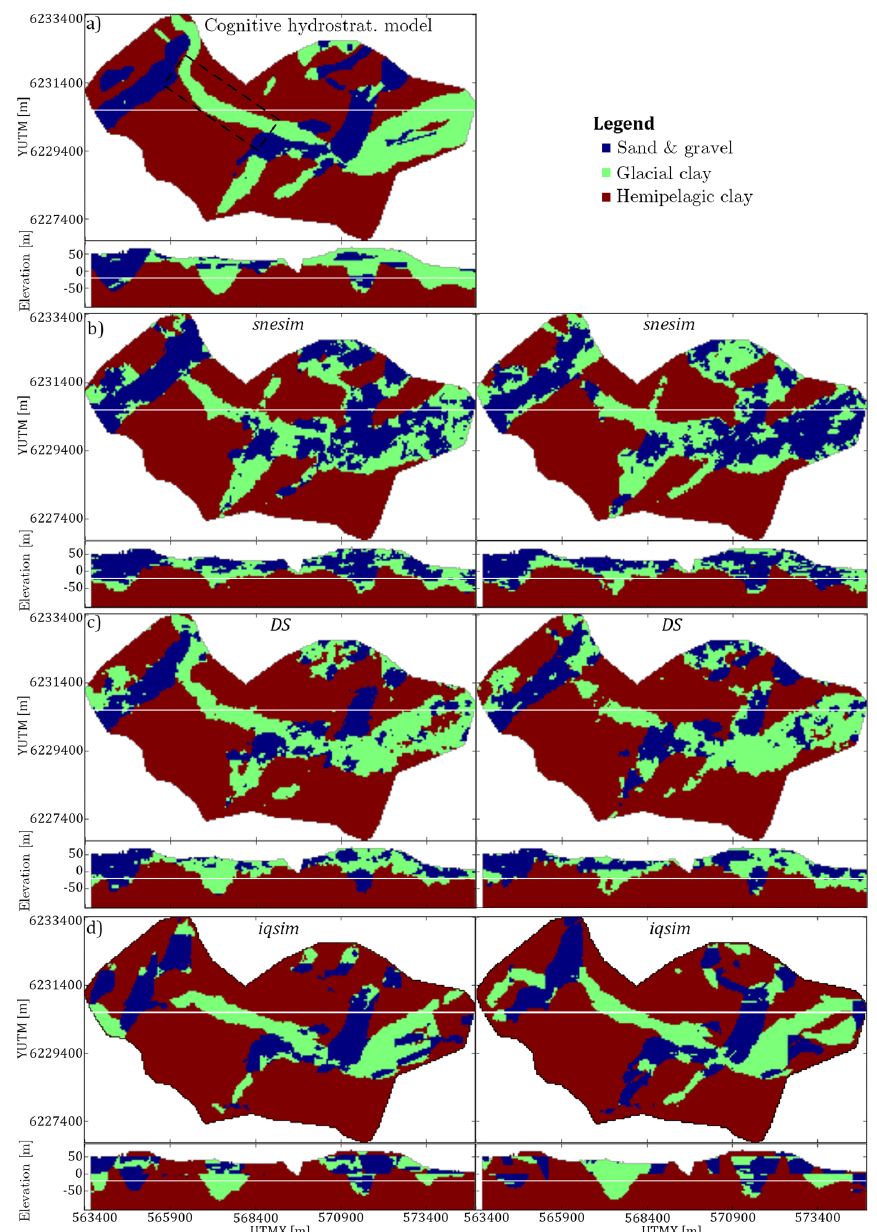
Figure 8. The hydrostratigraphic MPS realizations are presented as horizontal slices centered on 20mb.s.l. and vertical cross sections intersecting at UTMY 6230150m. (a) shows the cognitive hydrostratigraphic model, with a west–northwest- to east–southeast-trending glacial clay valley marked by a box; (b) shows two snesim realizations; (c) shows two DS realizations; and (d) shows two iqsim